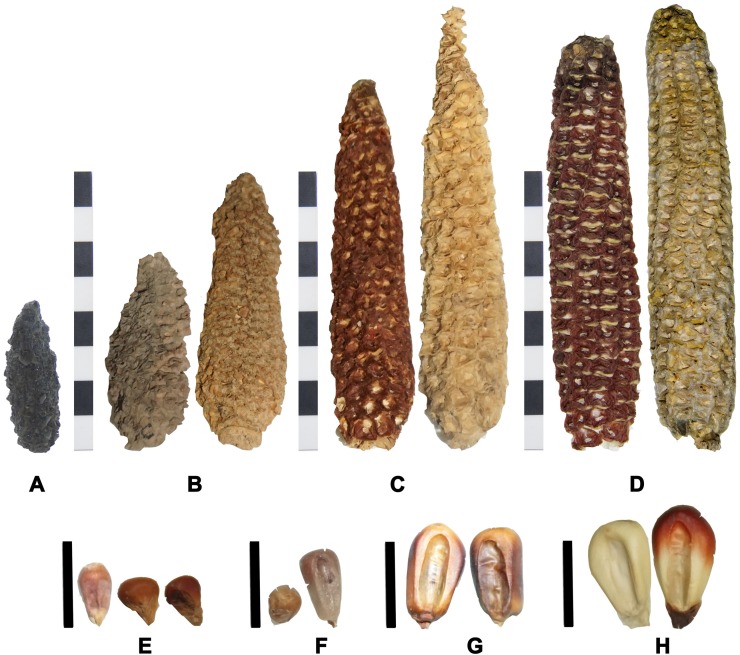
Cobs and kernels from archaeological and modern populations.A) cobs from Pircas sites, B) cobs from Tarapacá 13, C) cobs from Tarapacá Viejo, D) modern cobs from Camiña and Tarapacá respectively. E) kernels from Pircas and Pintados 1307, F) kernels from Tarapacá 13, G) kernels from Tarapacá 49, H) modern kernels from Camiña and Tarapacá, respectively. Scale bar cobs = 8 cm, scale bar kernels = 1cm.